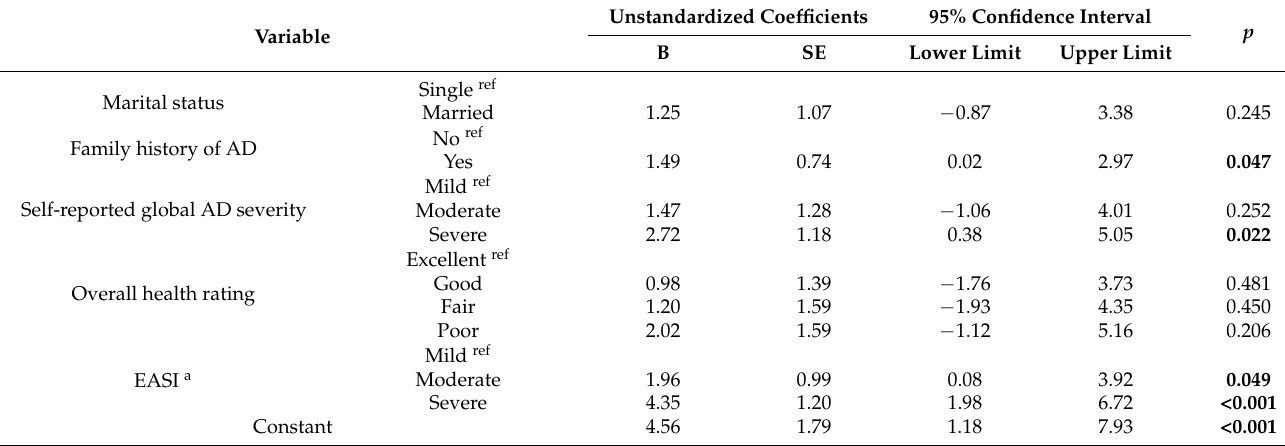
Table 7. Multiple linear regression model for estimating factors influencing the overall